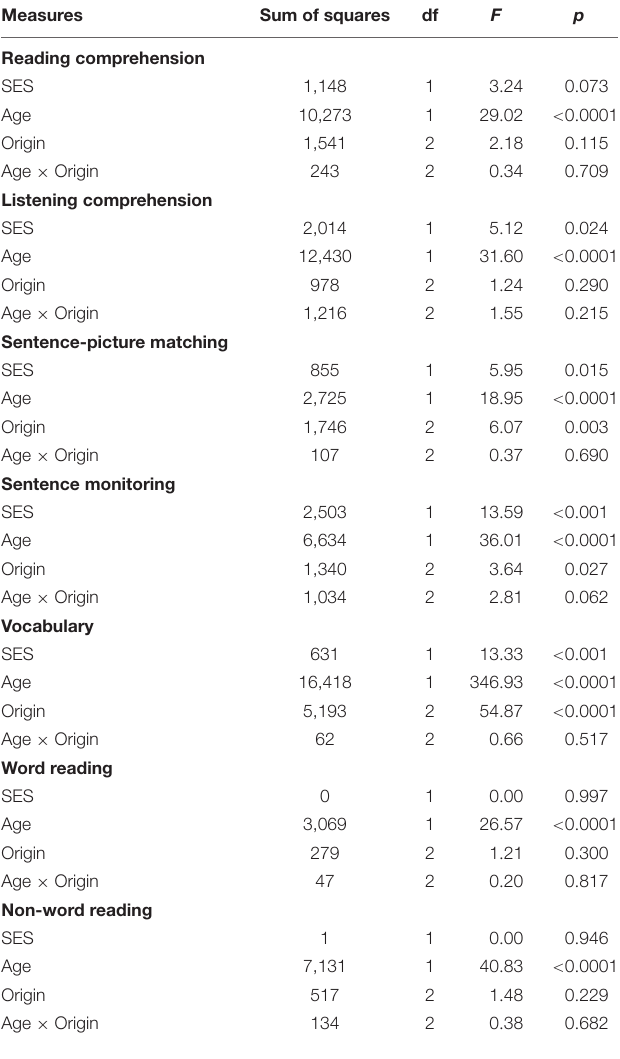
TABLE 2 | Analysis of covariance